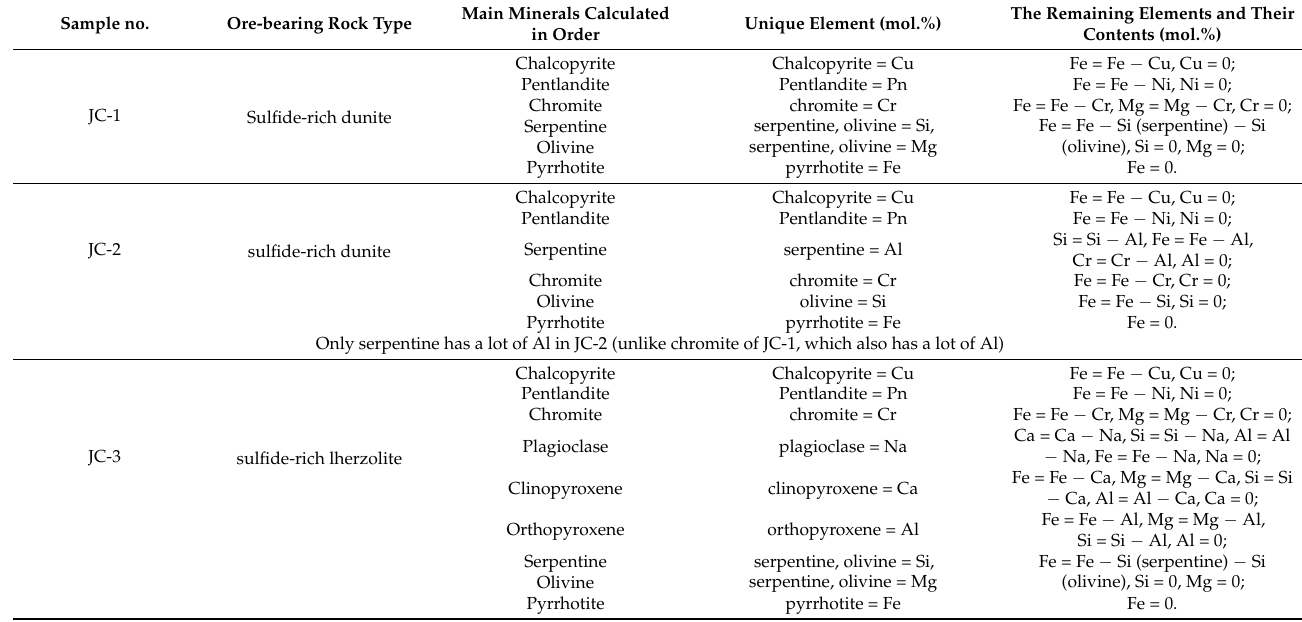
Table 7. The details of the “CIPW” calculations for the three net-textured ore samples (JC-1, 2, and 3). Sample